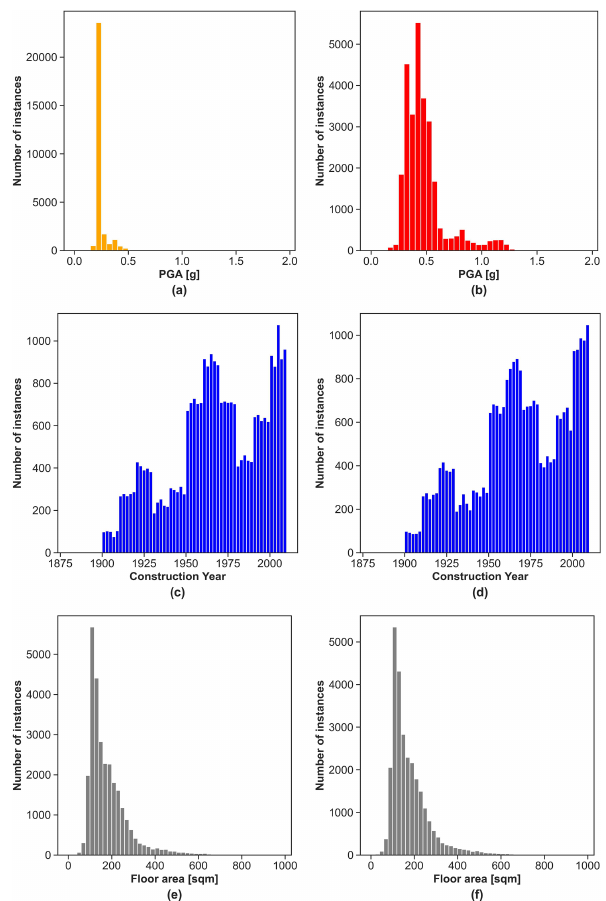
Figure 6. Distribution of the numerical attributes: (a) peak ground acceleration (PGA) for 4 September 2010, (b) peak ground acceleration (PGA) for 22 February 2011, (c) construction year for the building claims related to the 4 September 2010 earthquake, (d) construction year for the building claims related to the 22 February 2011 earthquake, (e) floor area for the building claims related to the 4 September 2010 earthquake, and (f) floor area for the building claims related to the 22 February 2011